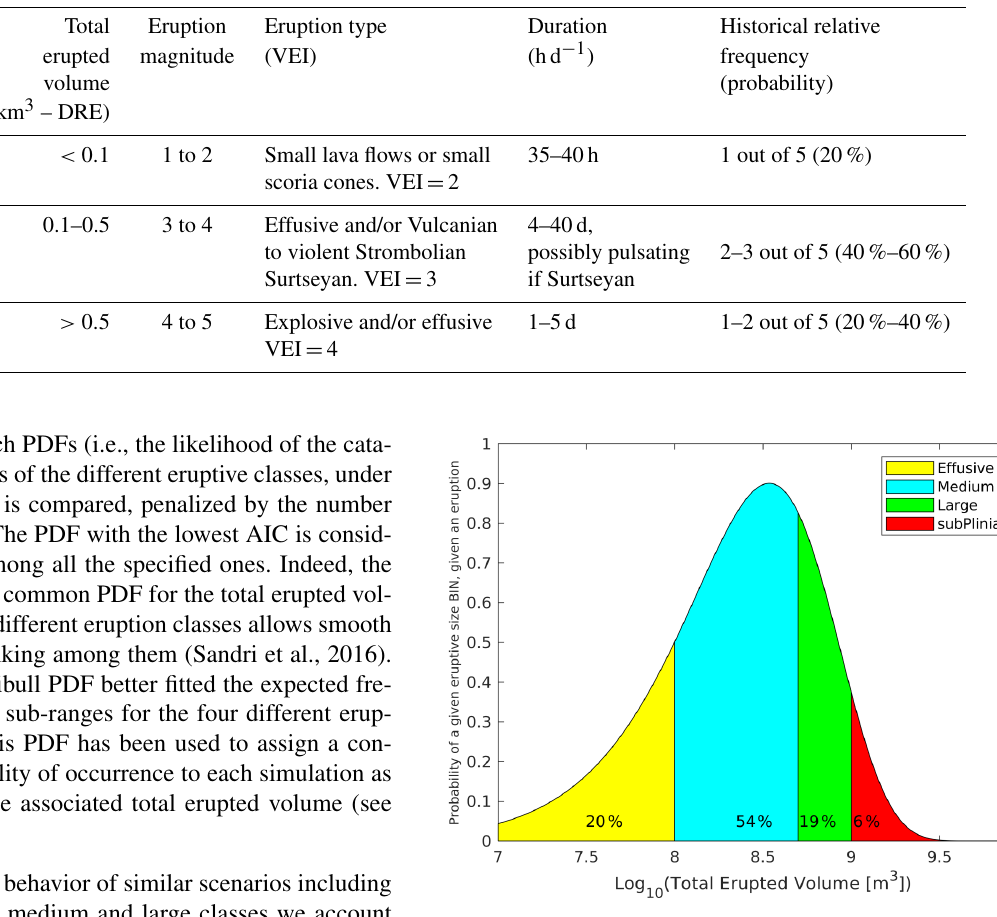
Figure 3. Weibull PDF describing the conditional probability of dif- ferent eruptive magnitudes in the case of an eruption at JM. The four colors cover the erupted volume ranges in the four “classi- cal” eruption classes for JM, classically synthesized into four rep- resentative scenarios with a fixed mass, neglecting the variability in volume around these scenarios. The area under the different parts of the plot corresponds to the probability of an effusive, medium, large, and sub-Plinian class range eruption respectively, conditional to eruption occurrence. These values are in agreement with previous studies for JM (Larsen et al., 2017; Gjerløw et al.,